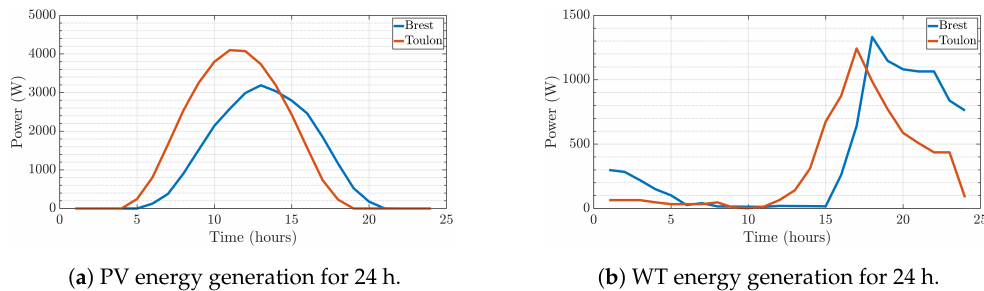
Figure 9. Case study 2: Renewable energy resources generation for Brest and Toulon.